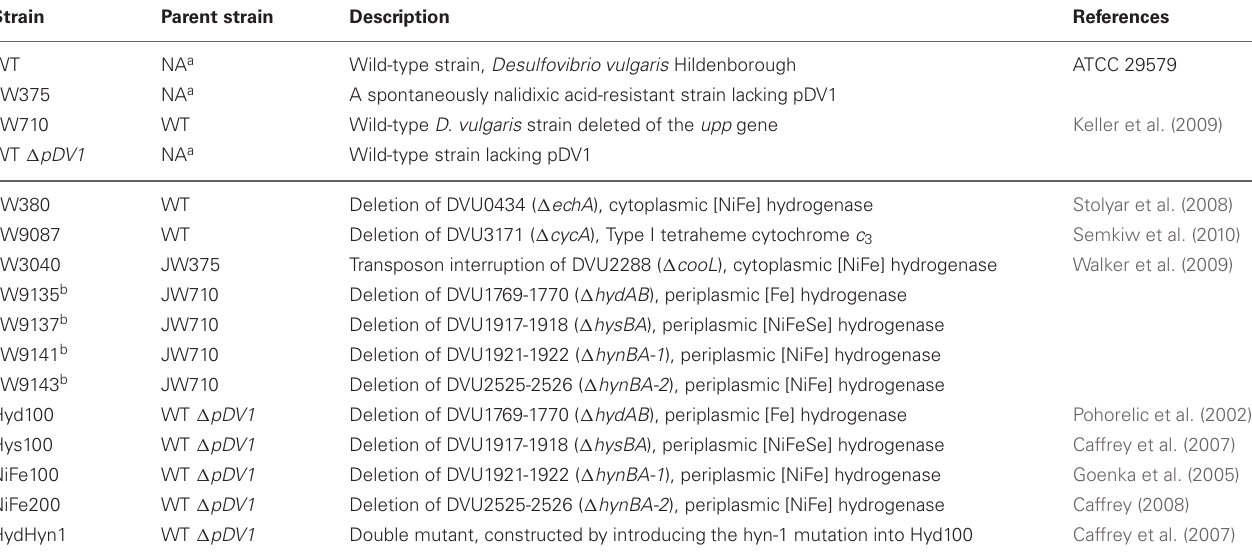
Table 1 | Desulfovibrio vulgaris strains used in this